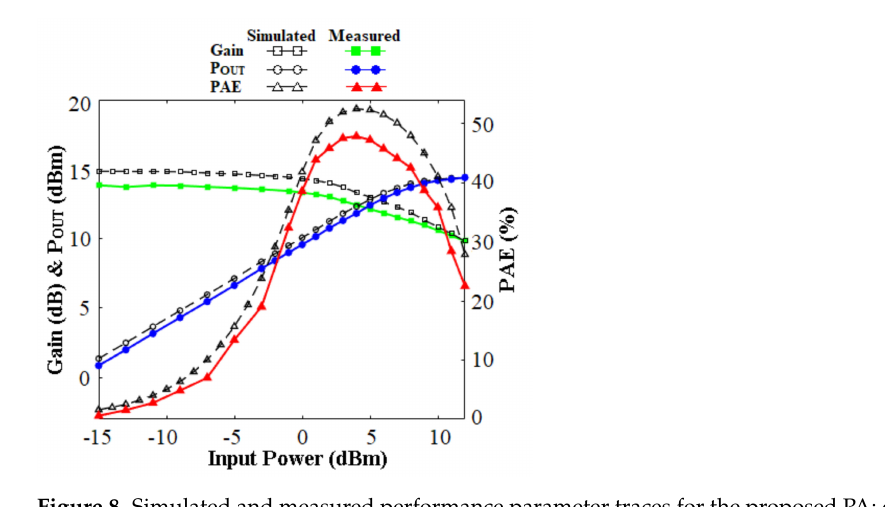
Figure 8. Simulated and measured performance parameter traces for the proposed PA: output power, gain, and PAE versus input power.